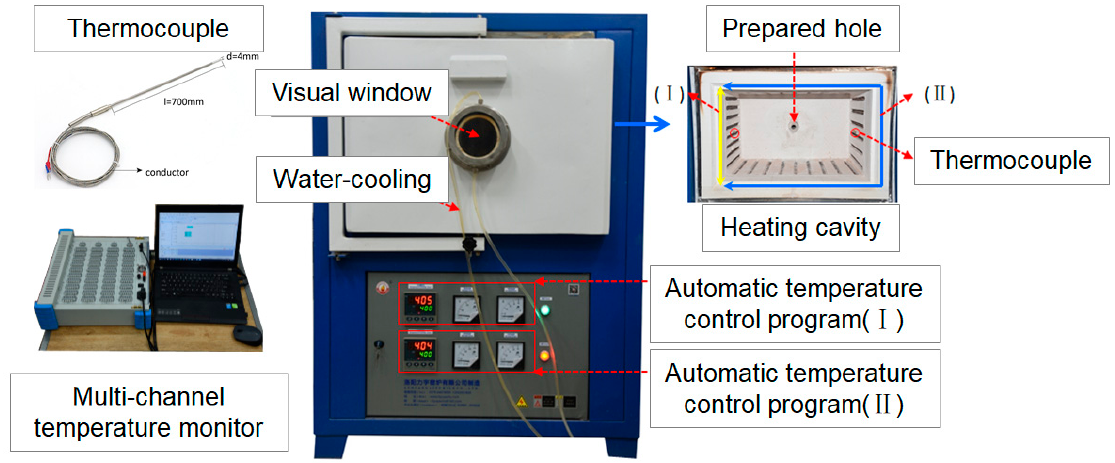
Figure 3. Muffle furnace and unidirectional heat transfer system.